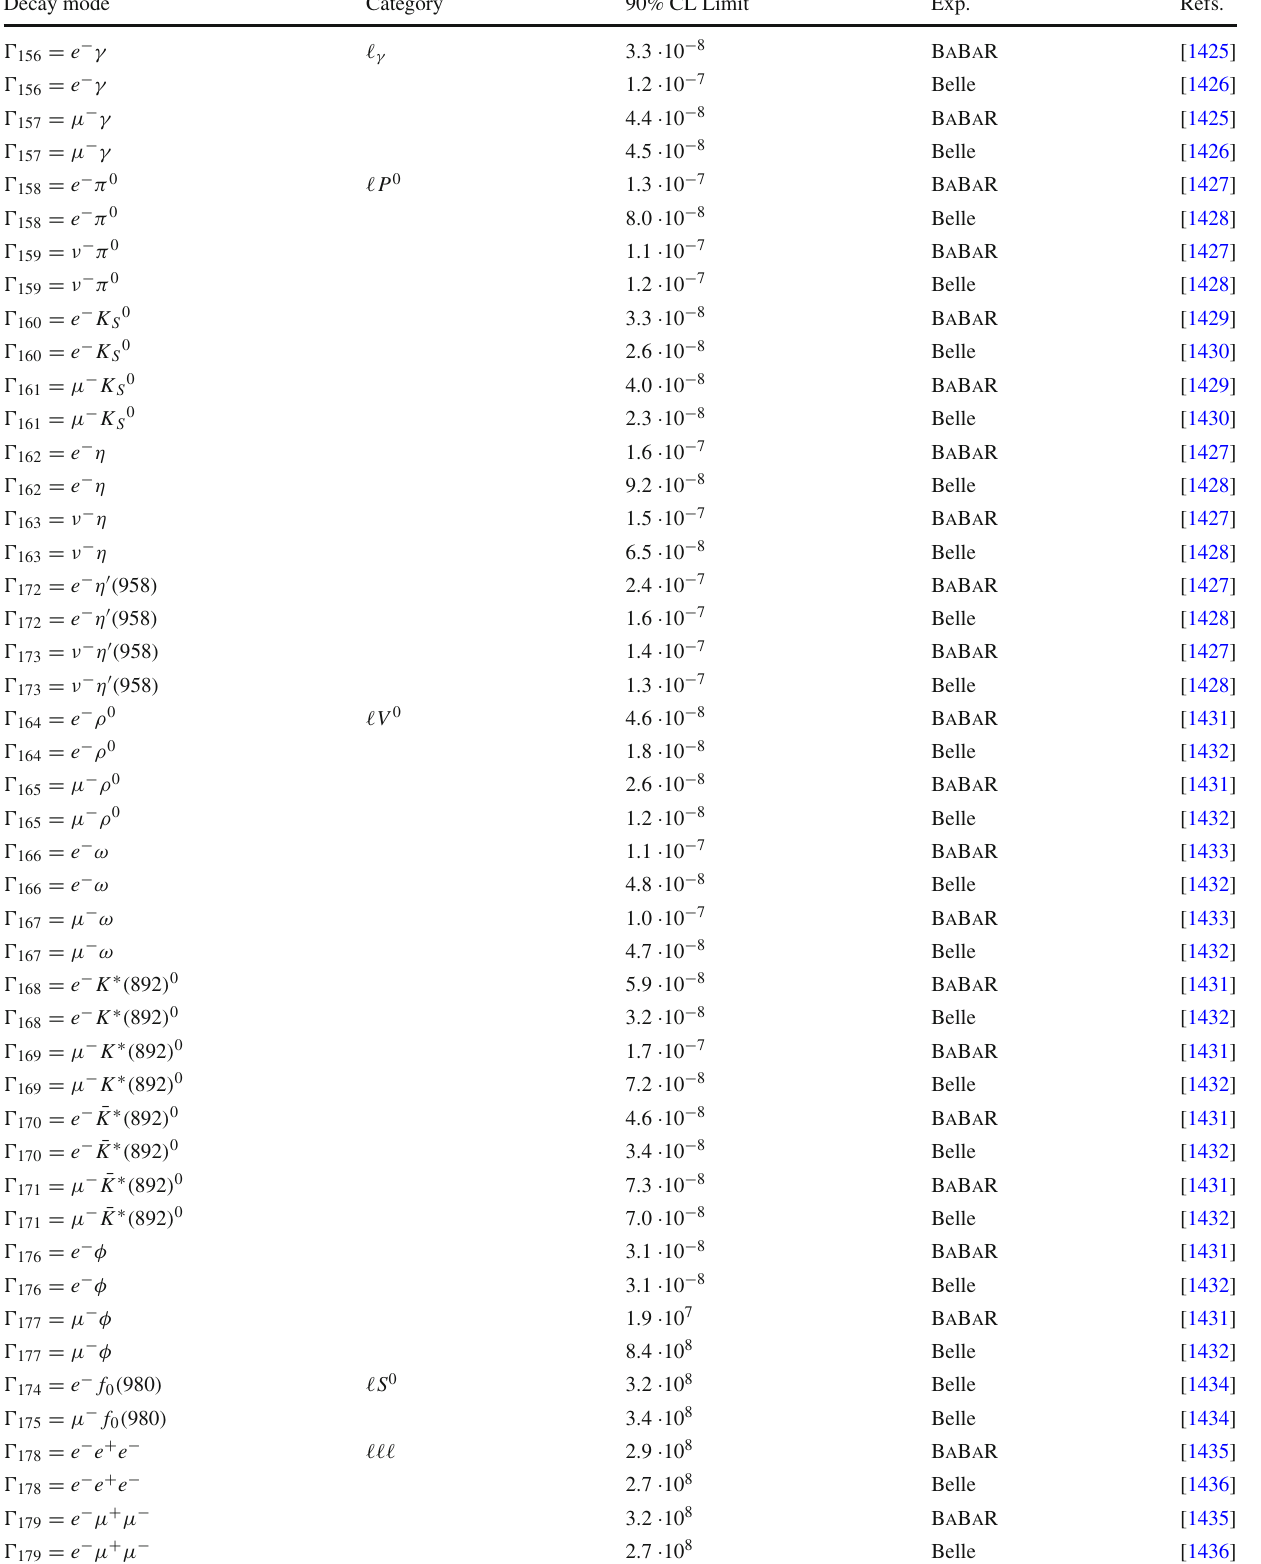
Table 317 Experimental upper limits on lepton flavour violating τ decays. The modes are grouped according to the properties of their final states. Modes with baryon number violation are labelled with “BNV” Decay mode Category 90% CL Limit Exp.